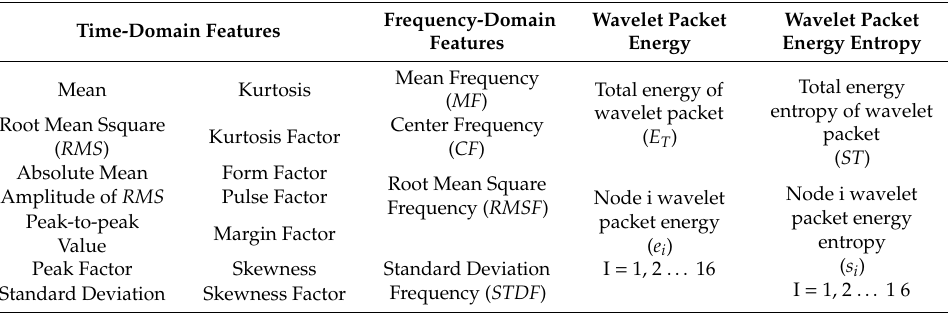
Table 5. Relevant features of